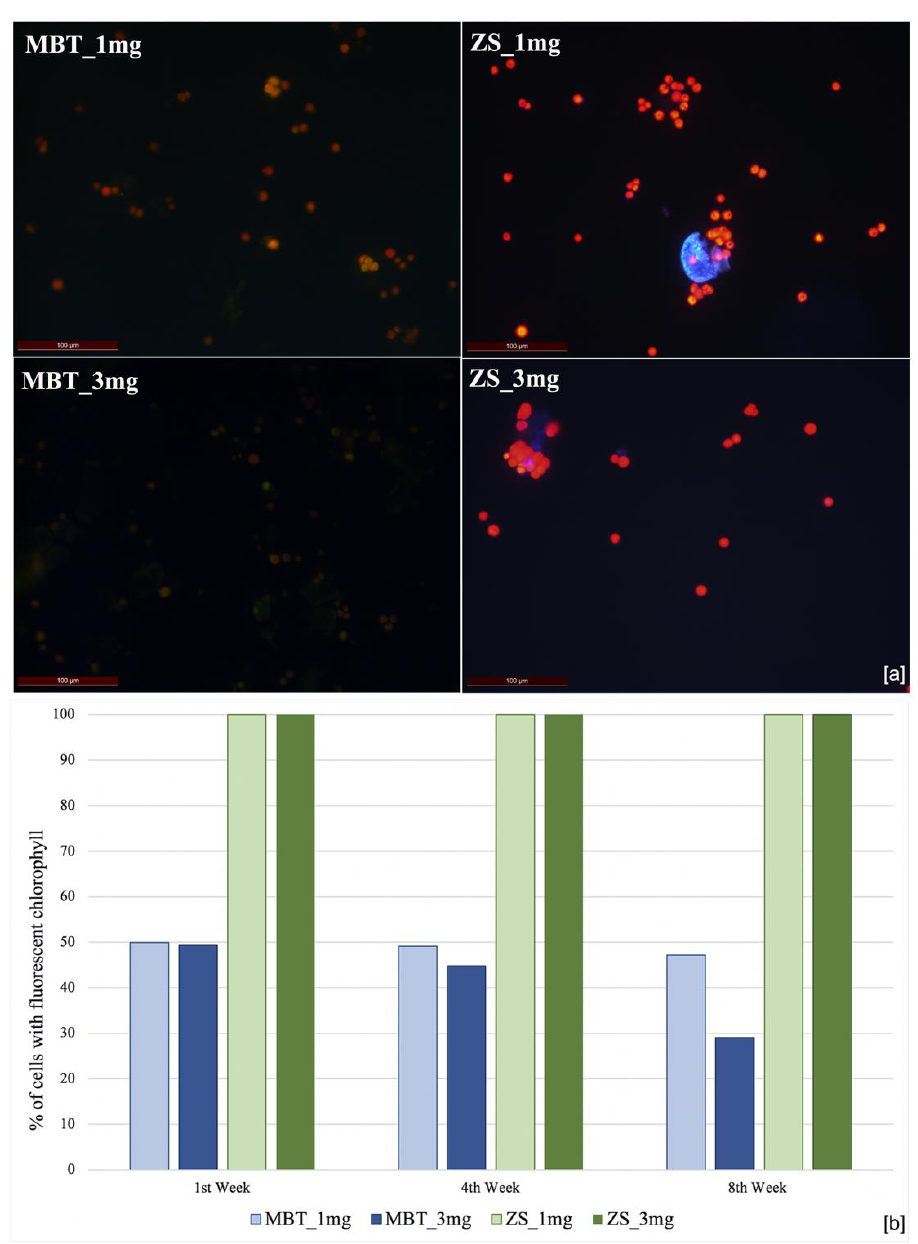
Figure 2. Evaluation of Zostera sodium salt (ZS) and 2-mercaptobenzothiazole (MBT) efficiency applied as free biocides in different concentrations (3 mg and 1 mg). ( a ) Optical microscope image in blue channel fluorescent light at the 8th week. The loss of fluorescence of chlorophyll (red) highlights the efficiency of the biocide. ( b ) Graph of red fluorescence percentage of culture treated with different concentrations of both free biocides. The decrease in fluorescent cells’ percentage highlights the efficiency of products.